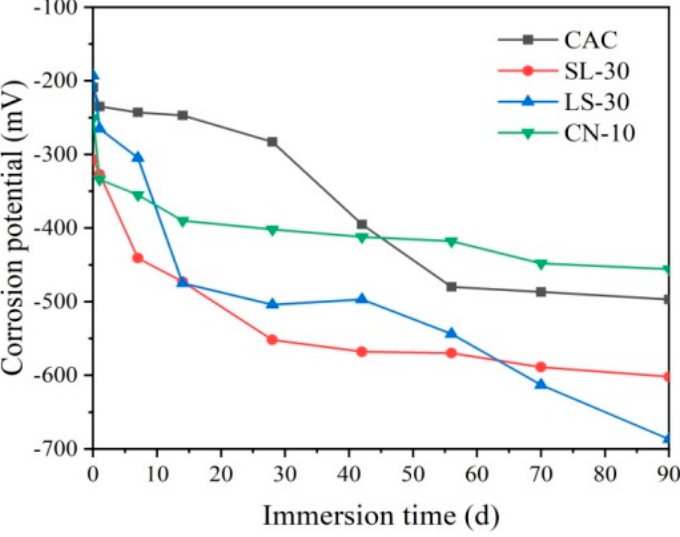
Figure 2. Corrosion potential of different reinforced CAC mortar electrodes.